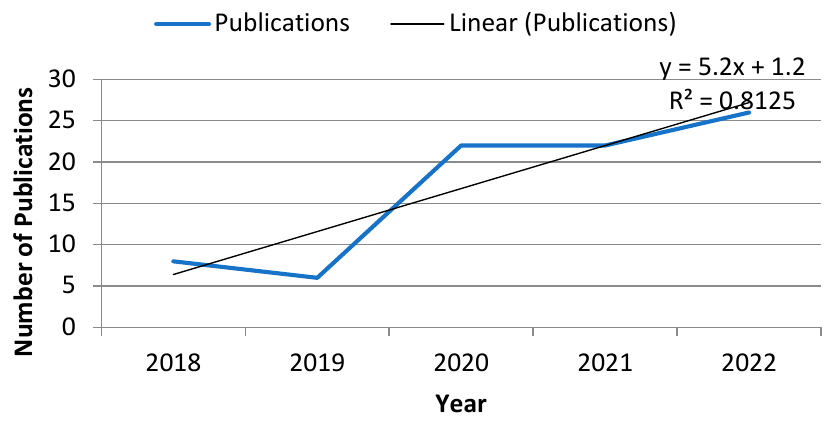
Figure 2. Publication Trend .